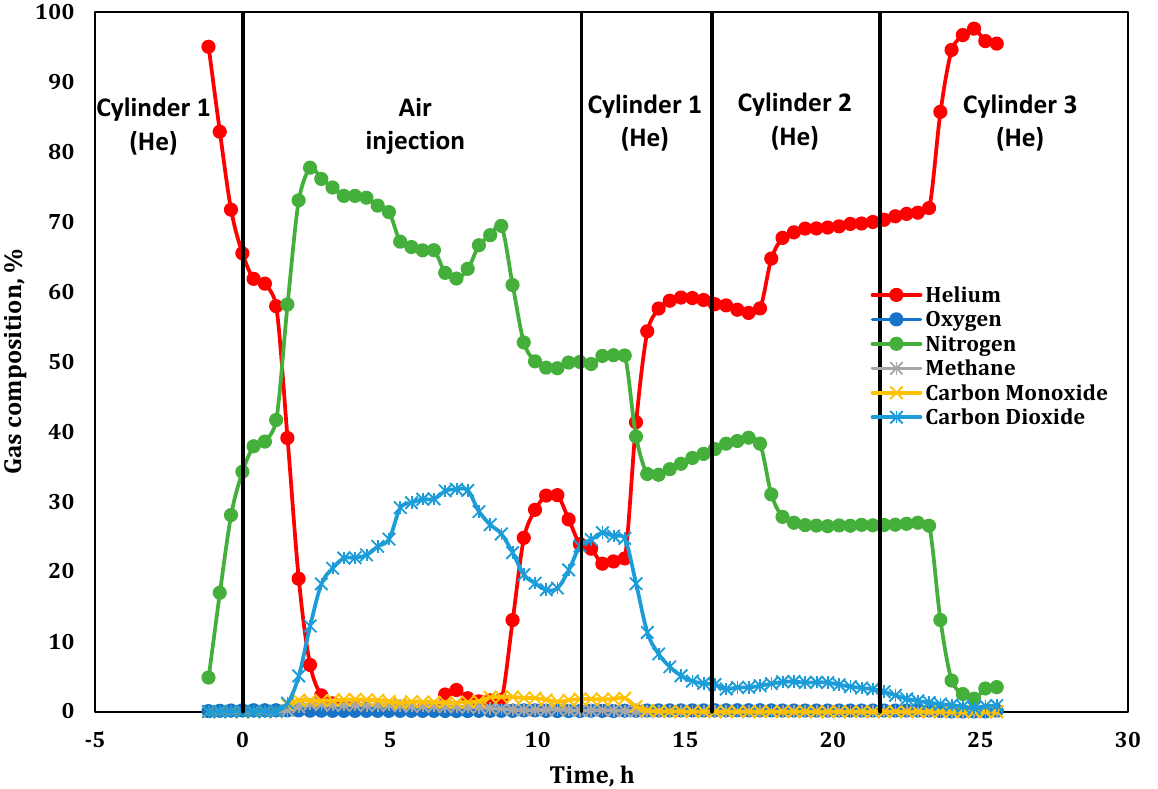
Figure 9. Composition of produced gas, including He for the vuggy CT test. As expected, for an ISC test using air injection, the combined N 2 and He (Cylinder 1) content in the effluent gas was detected throughout the experiment. Between 14 and 17 h, the N 2 and He concentrations of Cylinder 1 (He) were 42 and 57%. At 15.8 h, when the gas cylinder was switched to Cylinder 2 (He) and after a 1.7 h delay, the gas composition changed to 72 and 27% for He and N 2 , respectively. After 21.6 h, the gas bottle was changed to Cylinder 3, which comprised pure He, allowing the N 2 to be completely purged from the system. An unexpected increase in the He concentration in the product gas was observed during the 6.5 to 13 h period. First, a sharp increase from 0 to 3%, followed by a decline to 1.5%, was observed. At approximately 8.5 to 9 h, the He concentration increased to more than 30%, indicating a leak from the He-filled annulus. Figure 10 focuses on the produced gas components with a concentration of less than 2 mole % in the produced gas (O 2 , light hydrocarbons, H 2 S and H 2 ). The O 2 present in this plot was associated with the injected air and the contaminated He from Cylinders 1 and 2. The O 2 concentration disappeared after switching the injection gas to Cylinder 3.